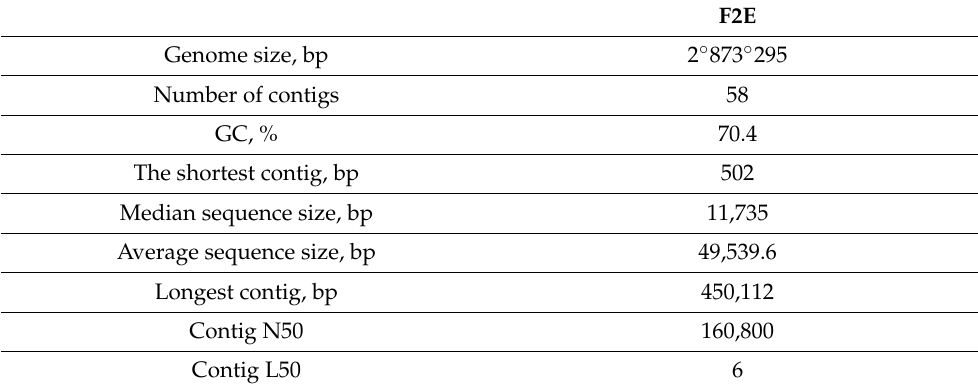
Longest contig, bp Contig N50 Contig